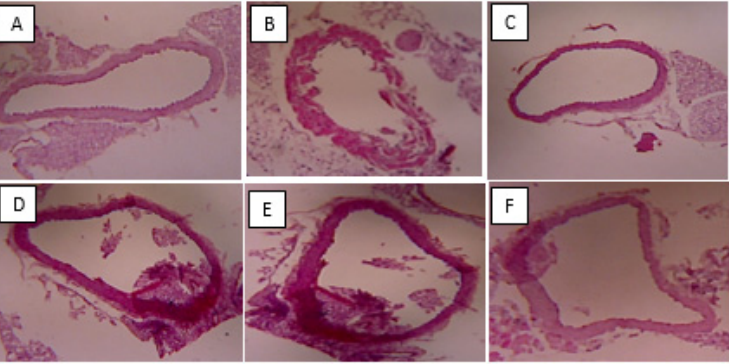
Figure 6. Visualization of 6 arteries. The results of HE staining were observed under a microscope at 40× magnification. ( A ) Normal, ( B ) Obes0, ( C ) Obes2, ( D ) Obes7, ( E ) Obes14, ( F )